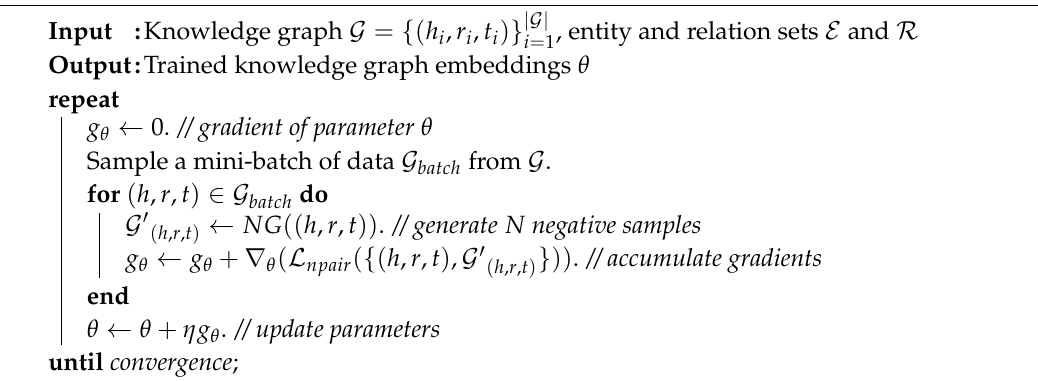
Algorithm 1: Learning Translation-based Knowledge Graph Embeddings by Considering Multiple Negative